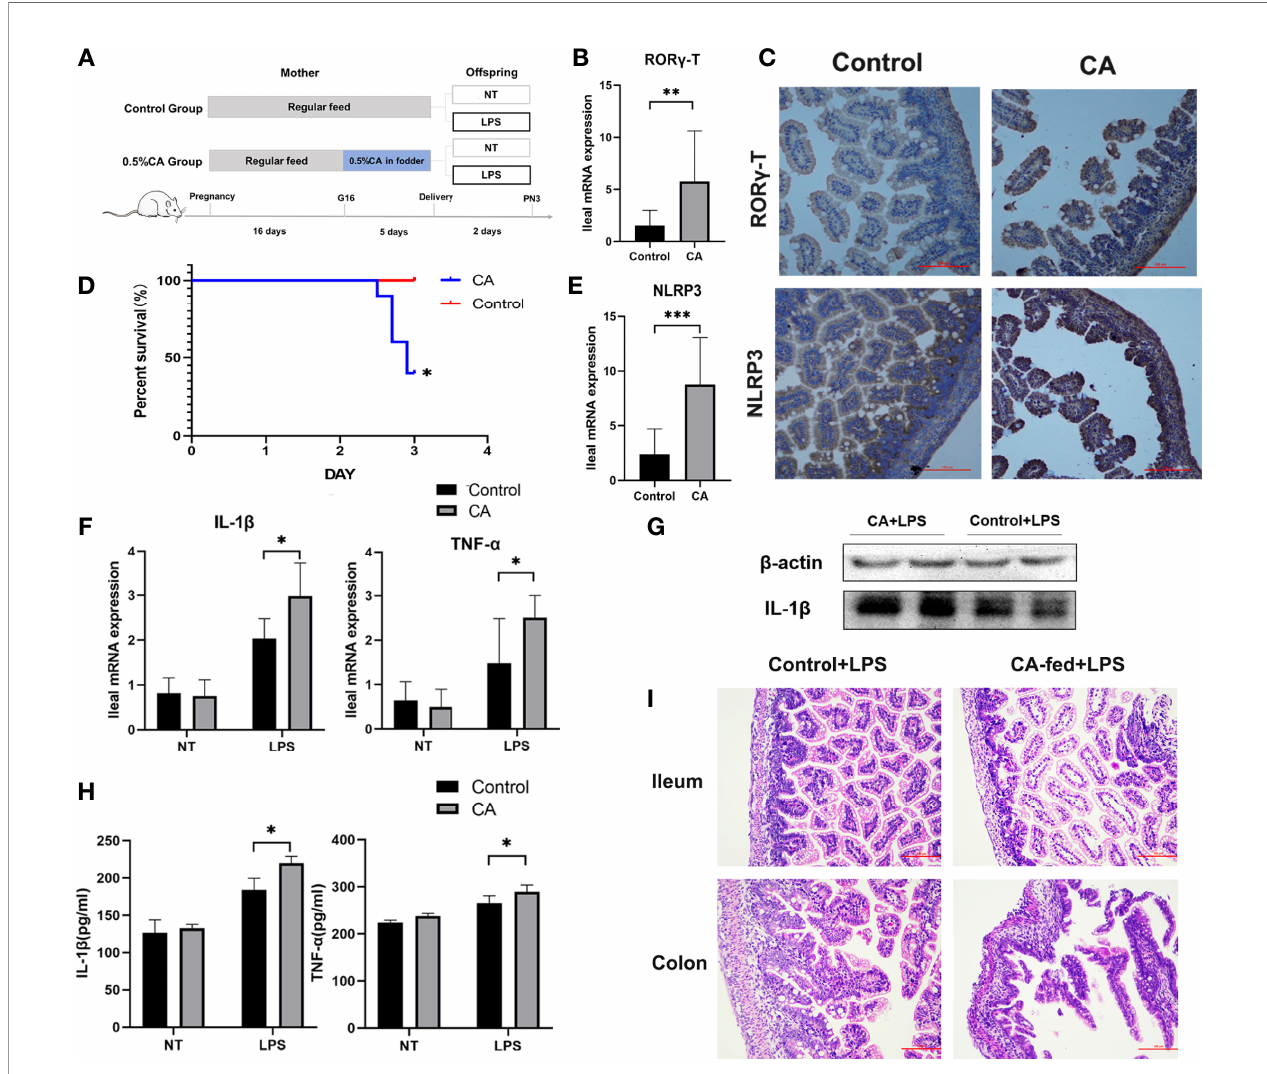
FIGURE 5 | Offspring from CA-fed mothers showed a predisposition to in fl ammatory disorders. (A) Flow diagram of the experimental procedure. (B, E) Ileum mRNA expression of ROR g -T and NLRP3 in two groups. (C) Immunohistochemical staining for ROR g -T and NLRP3 (brown) in the 1st day ileum tissue section. (D) Survival analyses after LPS exposure. (F) Ileal mRNA expression of IL-1 b and TNF- a upon LPS exposure in two groups. (G) Western blot analysis of IL-1 b in the ileum. (H) IL-1 b and TNF- a serum levels upon LPS exposure in two groups. (I) Microscopic observation of the ileum and colon tissue with hematoxylin and eosin (HE) staining. Scale bar, 100 mm. Magni fi cation, ×200. *p < 0.05, **p < 0.01, ***p<0.001. N